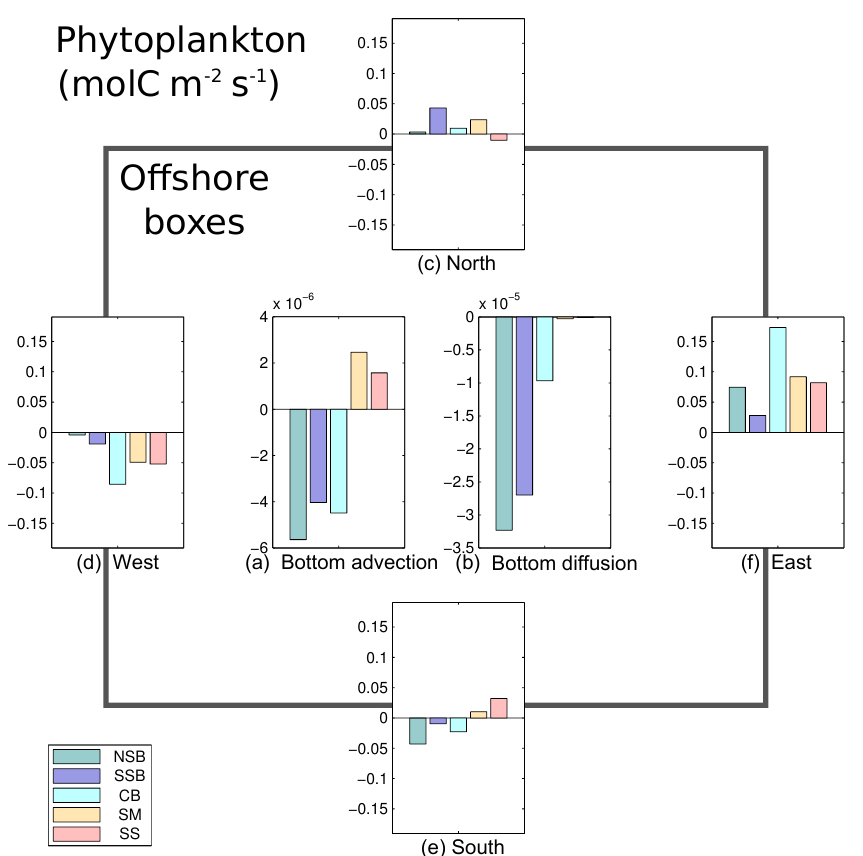
Figure 11. Spring mean (March–May) of vertical phytoplankton fluxes at the bottom of the offshore boxes by (a) advection and (b) diffusion (vertical mixing) and (c–f) lateral fluxes at the (c) northern, (d) western, (e) southern and (f) eastern boundaries (defined as positive inward and upward) (mol Cm − 2 s − 1 ) . Each colour corresponds to a box (see legend): northern Saharan Bank (NSB), southern Saharan Bank (SSB), Cape Blanc area (CB), Senegalo-Mauritanian region (SM) and southern Senegal region (SS).